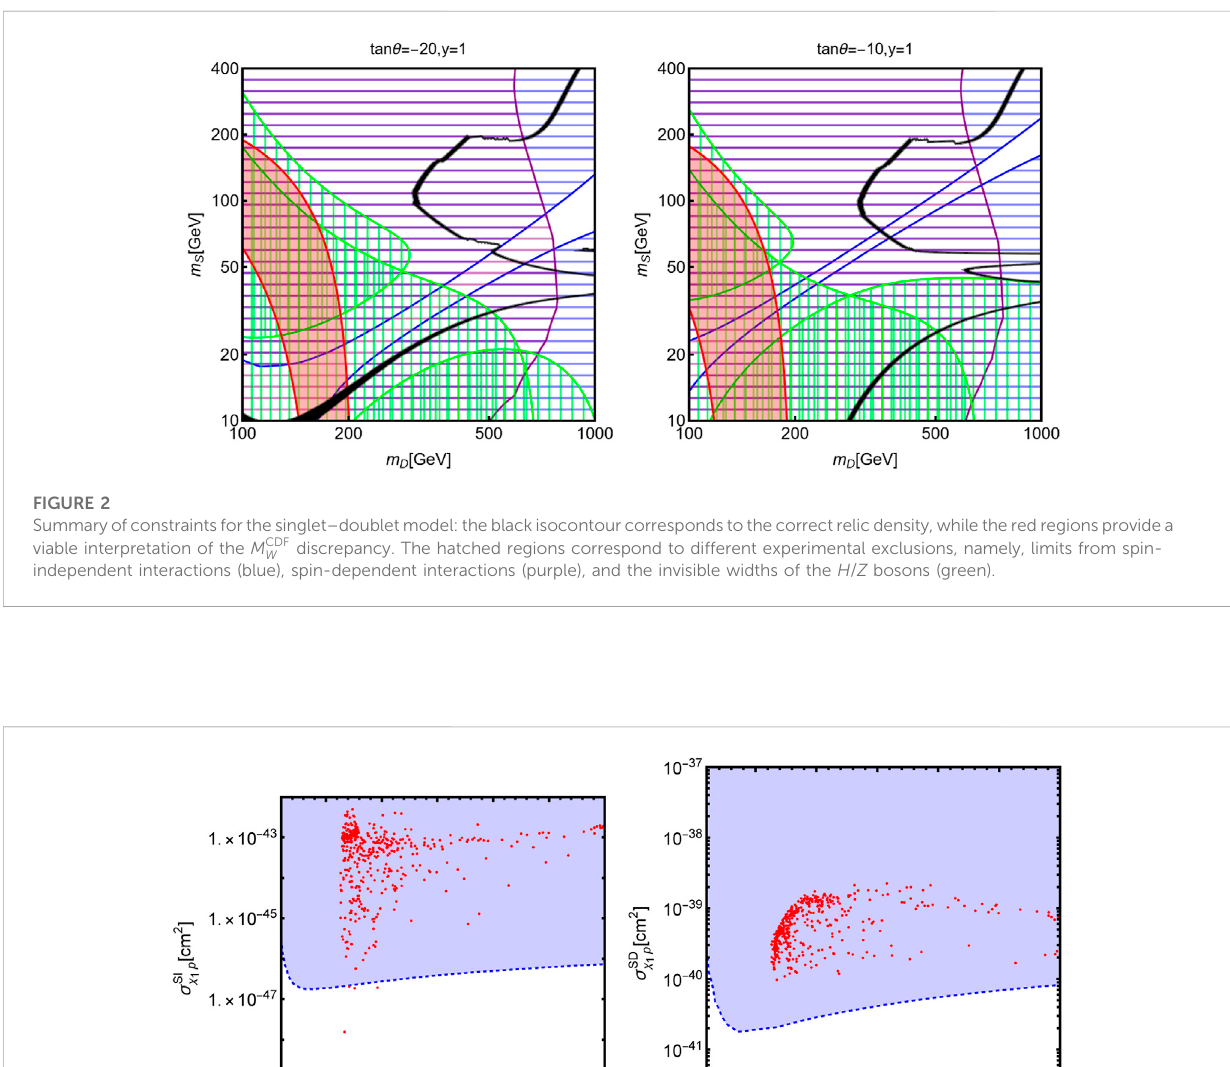
) and ( m χ ) planes. , σ SI χ , σ SD χ 1 1 1 p 1 p